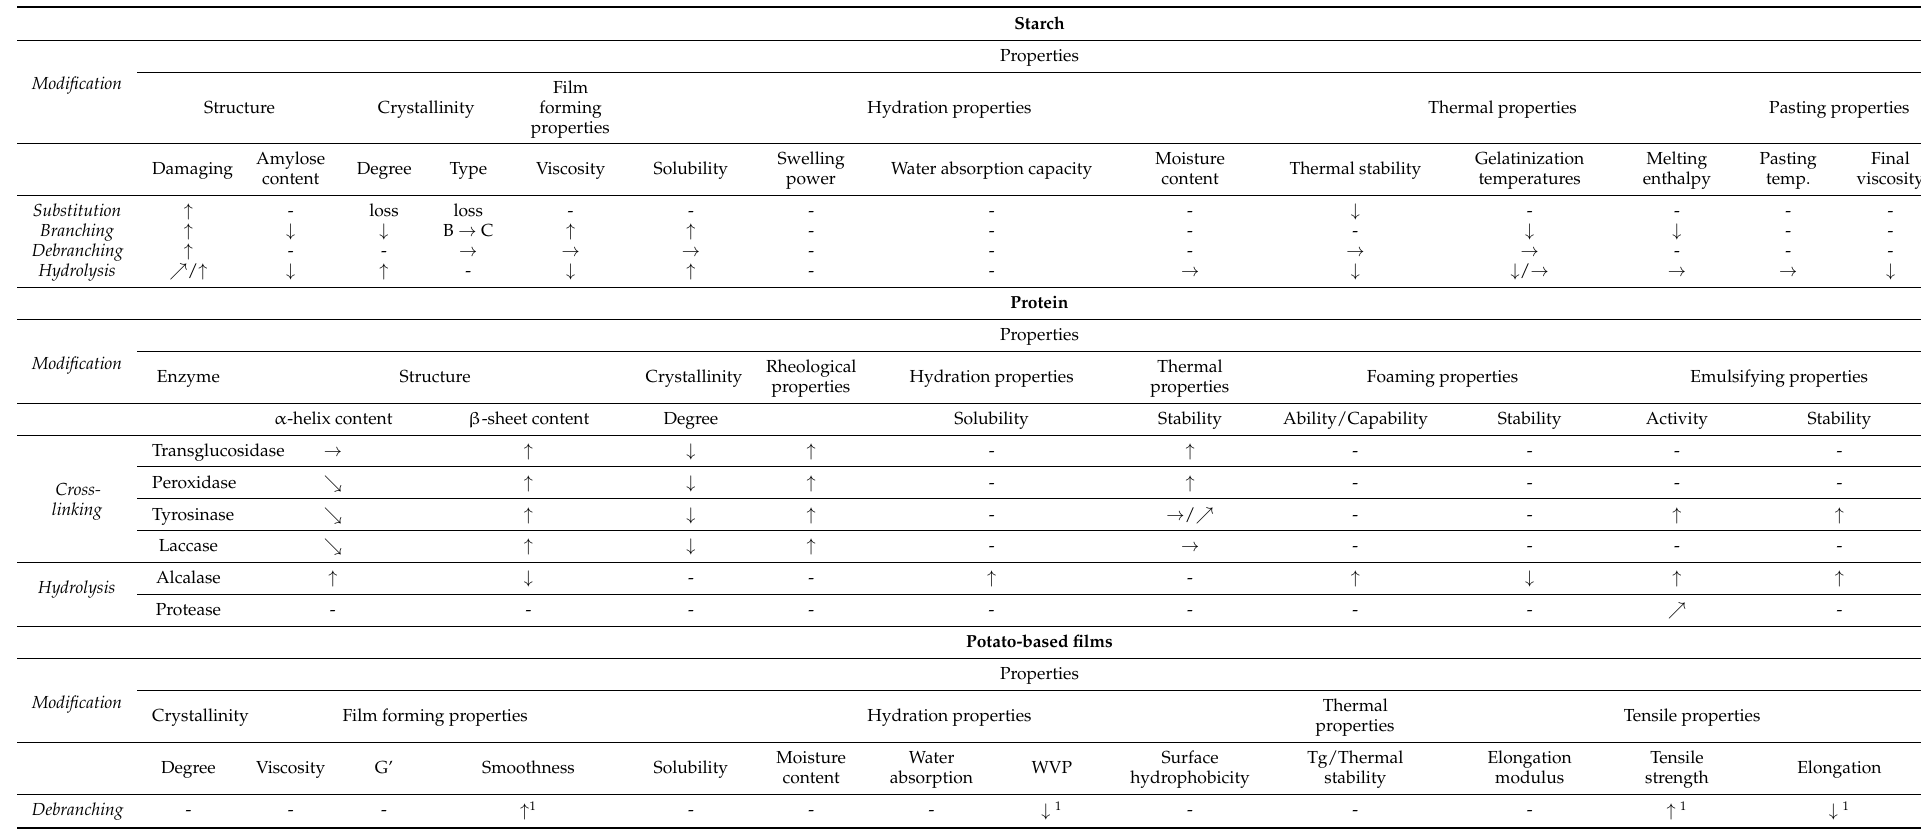
Table 4. General overview of changes induced by different biochemical modification methods on potato starch, potato protein and potato-based films structure and properties (specific processing parameters or changes in processing parameters are not considered here, but can be looked up above). Abbrevations and